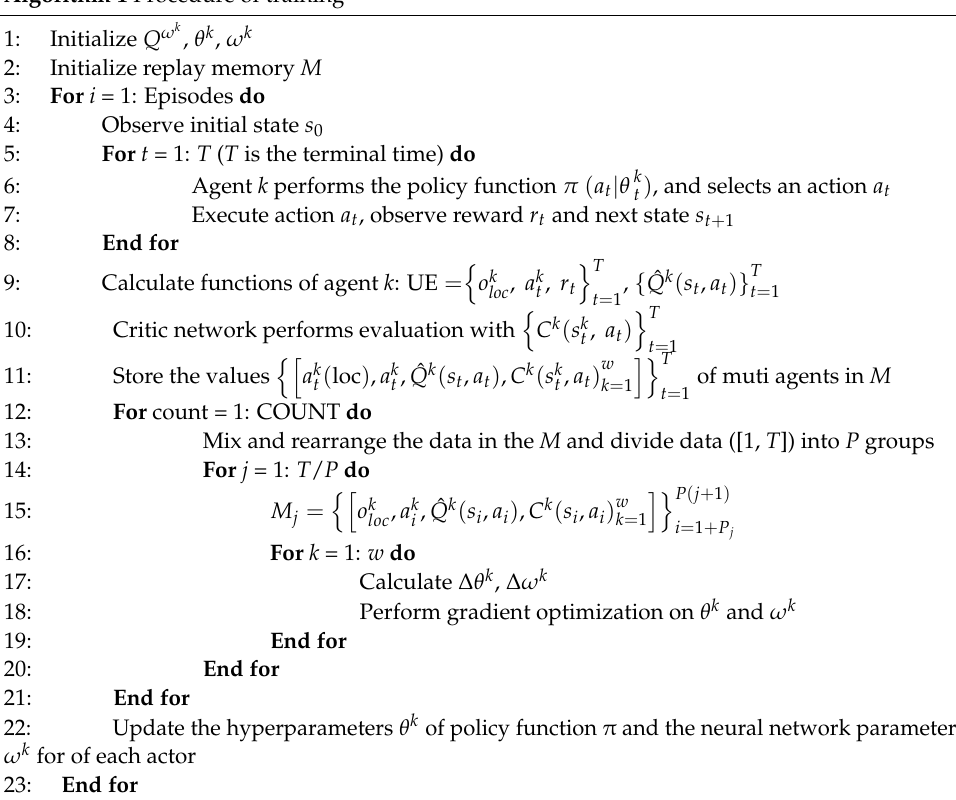
Algorithm 1 Procedure of training